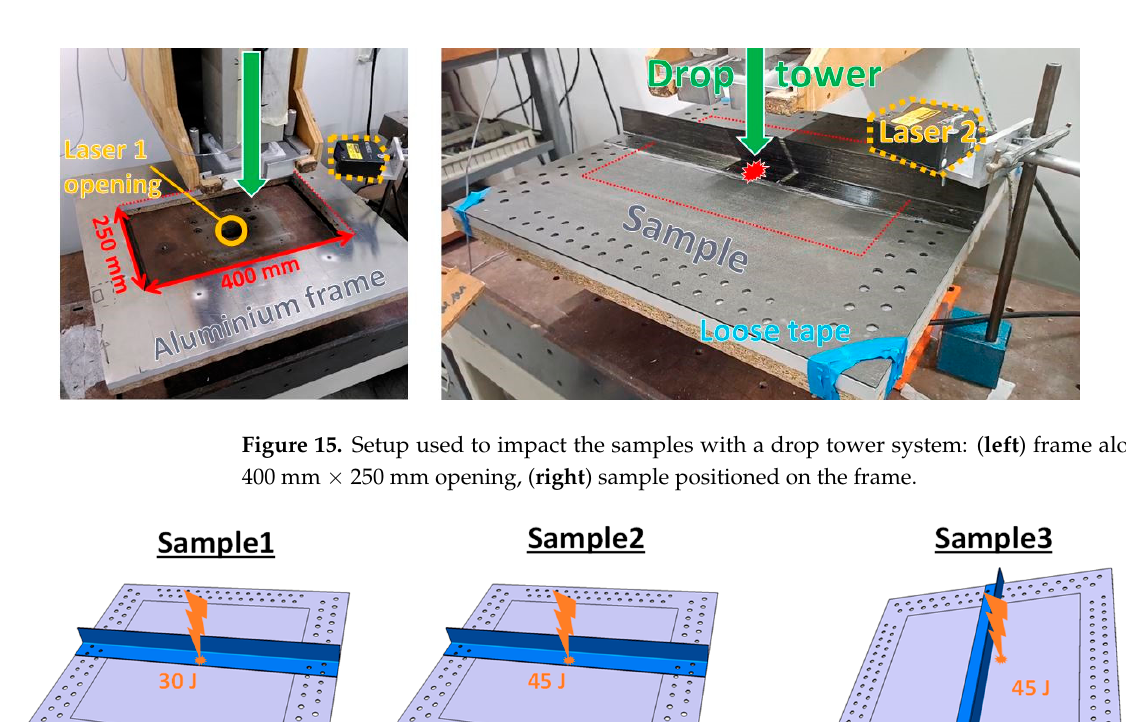
Figure 15. Setup used to impact the samples with a drop tower system: ( left ) frame alone with a 400 mm × 250 mm opening, ( right ) sample positioned on the frame.